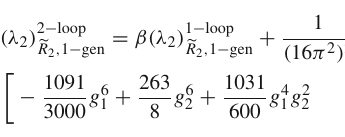
for higher Yukawa cases due to the large effects from the combined terms of Y 2 and Y 3 . As expected, Y 3 for three gen- erations of S 3 decreases monotonically with energy and hits the divergence at 10 19 . 7 GeV, while both Y 2 and Y 3 diverge (cid:2) R 2 + S 3 case. How- at 10 14 . 4 GeV for the three-generation ever, Y 2 shows different behaviour for large Yukawa. For (cid:2) R 2 case, as can be observed from Fig. 23b, it initially the decreases with scale, then reaches a minimum and gradu- (cid:2) R 2 + S 3 case, it increases with ally starts increasing. For the energy from the beginning, then reaches a maximum and starts to fall off, but suddenly blows up at 10 14 . 4